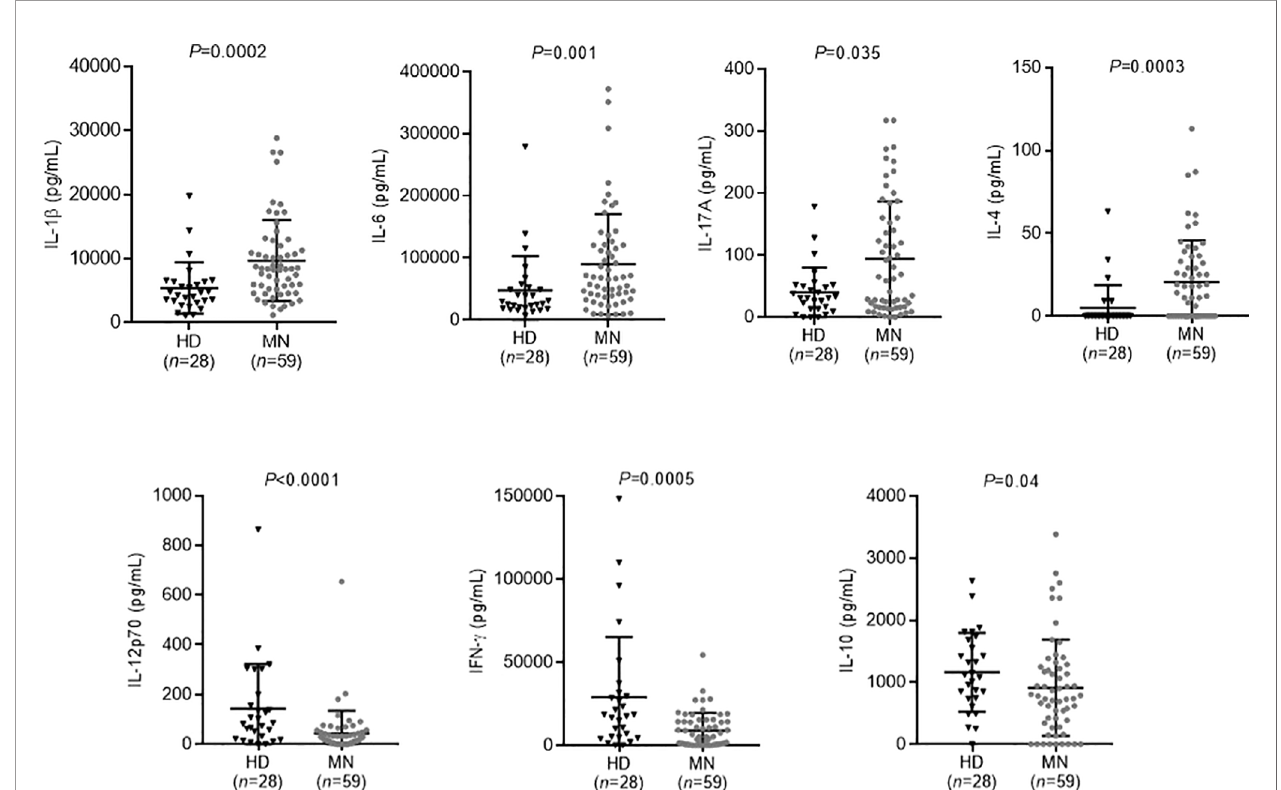
FIGURE 2 | Serum cytokine levels in membranous nephropathy (MN) patients and healthy donors after in vitro stimulation of immune cells by both anti-CD3 and TLR 7/8 agonist. Compared to healthy donors, MN patients had increased levels of IL-1 b , IL-6, IL-17A, and IL-4, and decreased levels of IL-12p70, IFN- g , and IL-10. A non-parametric two-tailed test (Mann-Whitney) was used to compare the level of cytokines in patients with that in healthy donors. MN, membranous nephropathy; HD, healthy